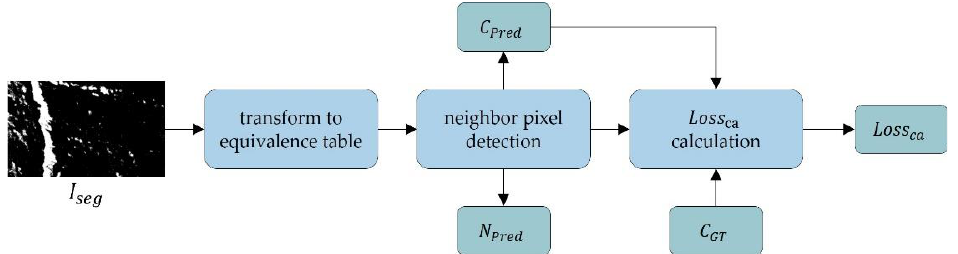
Figure 8. Structure of the connectivity attention loss computation.